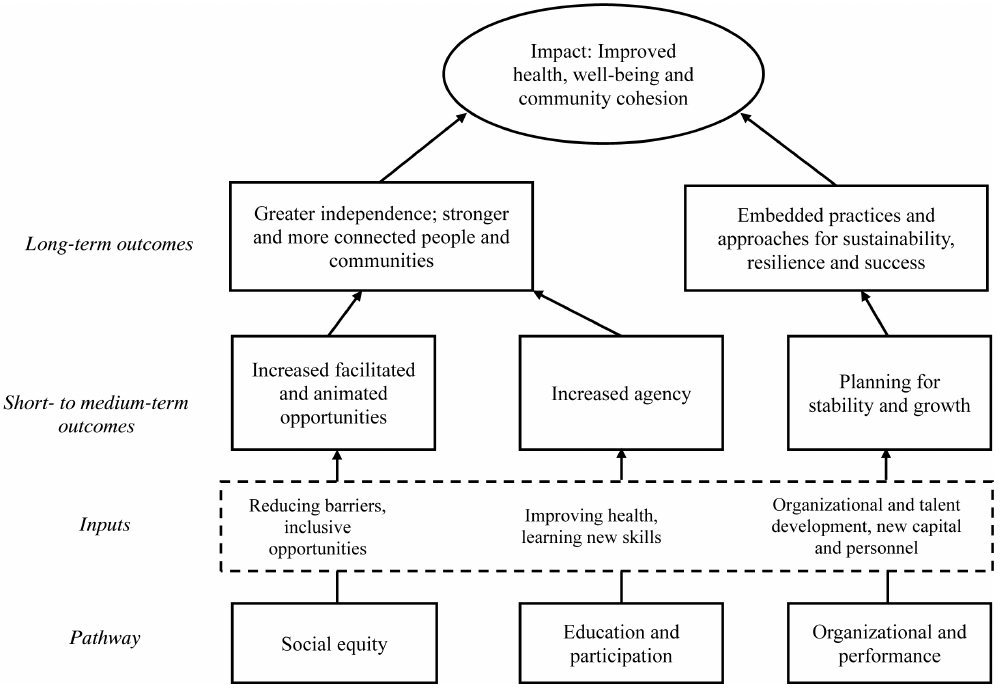
Figure 2: Conceptual model depicting nature and scope of outcomes perceived by